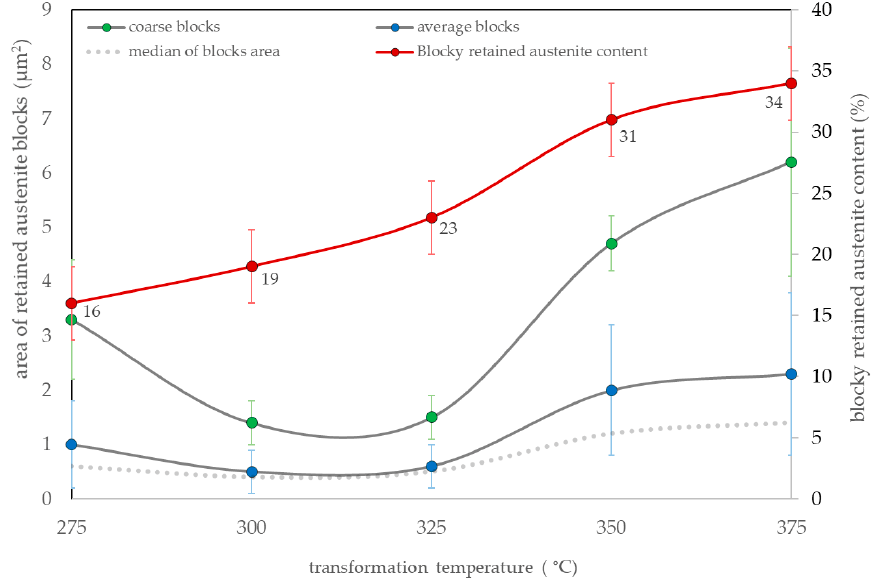
Figure 12. Quantitative analysis of retained austenite blocks expressed as surface area based on graphical image editing. Coarse blocks of retained austenite, the average surface area of blocky austenite, a median of measurements, and the total content of blocky retained austenite.